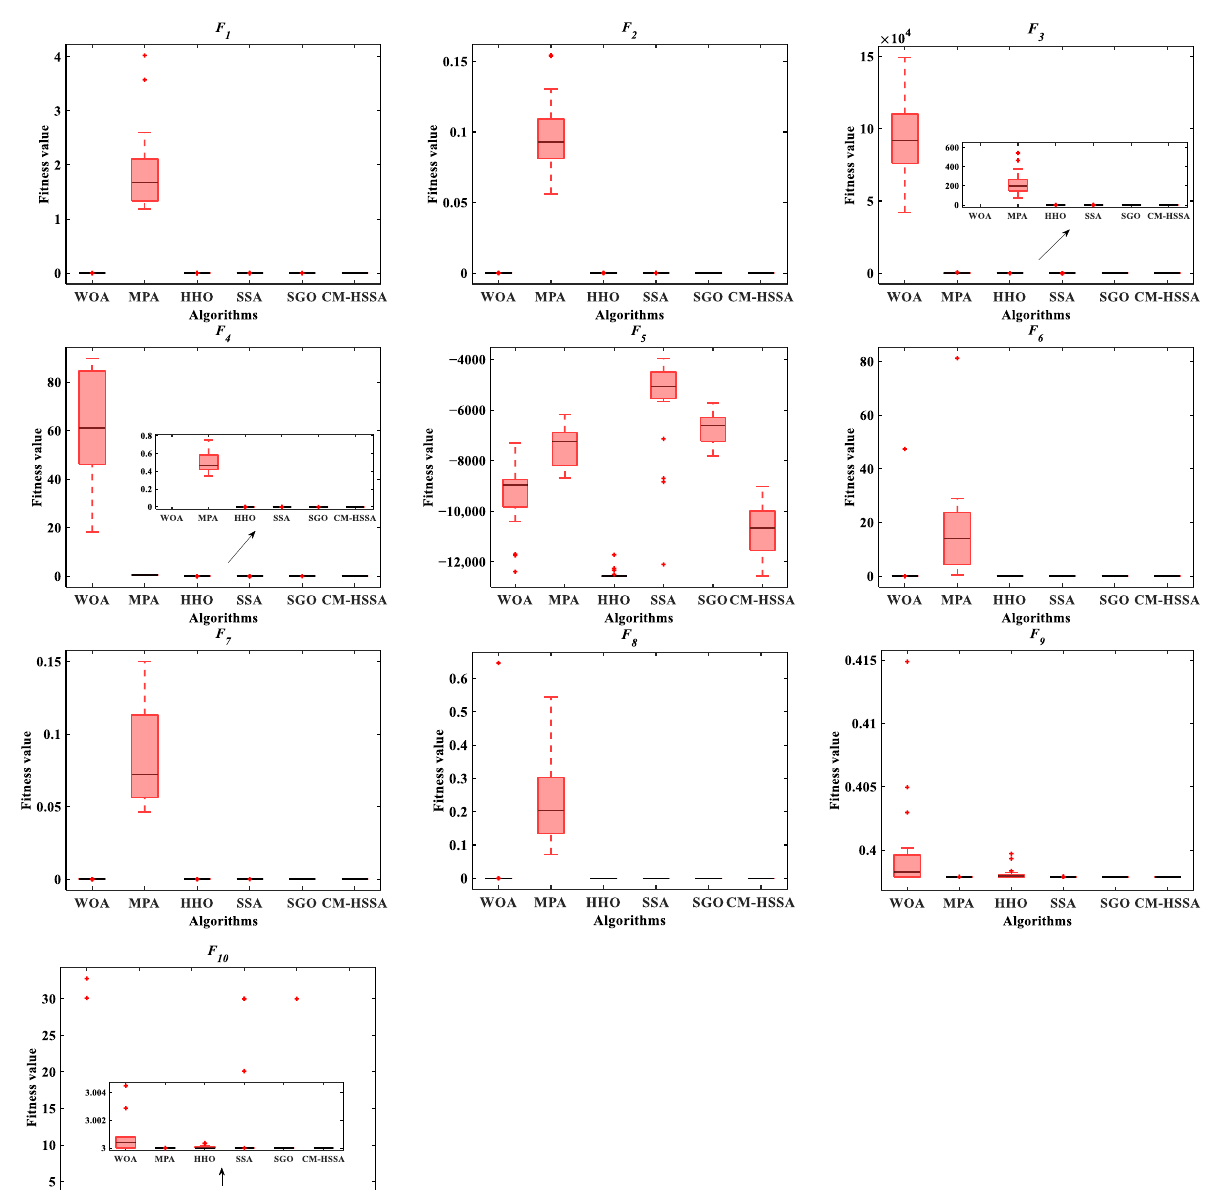
Figure 9. Boxplot of six algorithms for benchmark functions.